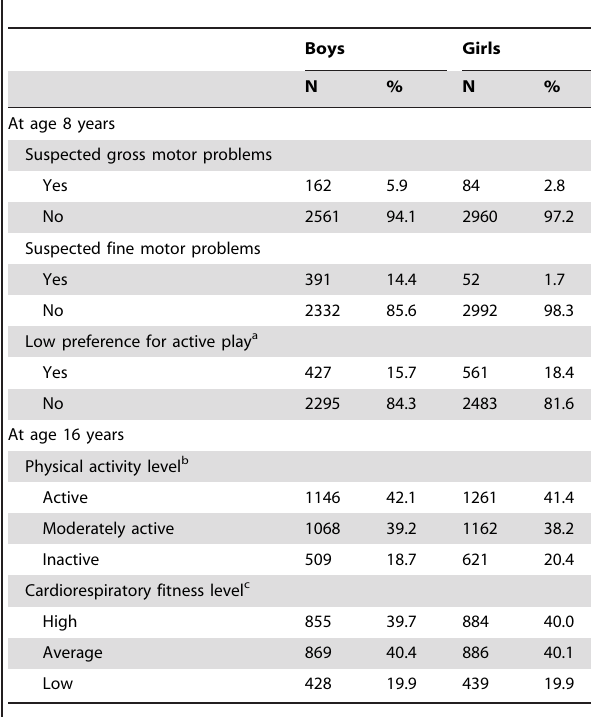
Table 1. Sample characteristics of boys and girls in the Northern Finland Birth Cohort